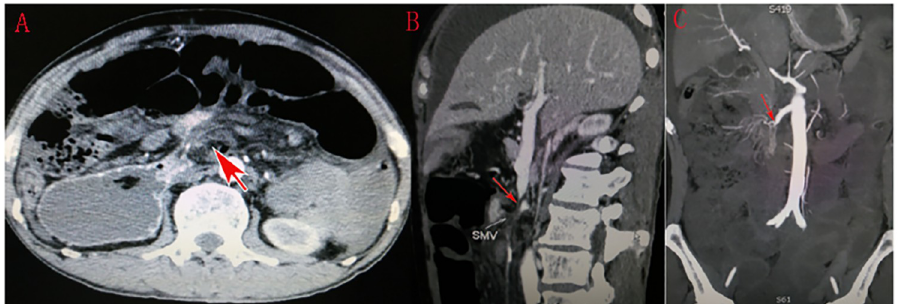
Fig 2. Three-dimensional abdominal CT showed the whirl sign of superior mesenteric vessels(A, red arrow). The longitudinaltaperingof superiormesenteric vein (B) and artery (C) were found in the coronal